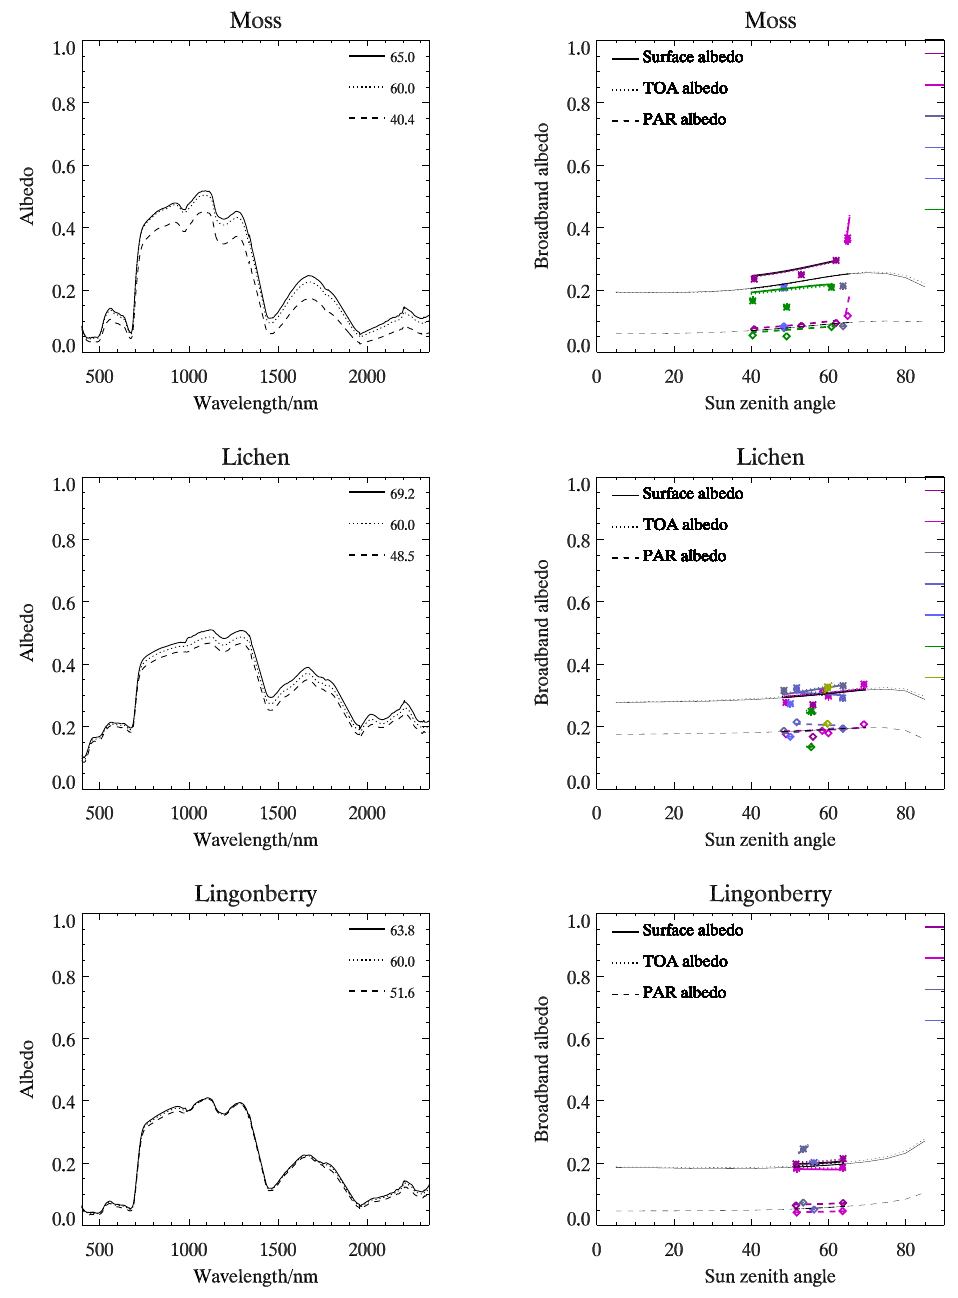
Figure 6. Left: The spectrally-resolved hemispherical albedo at three angles of incidence: maximum, minimum and 60 ◦ (interpolated). Right: recovered broadband surface albedo (solid line, +), TOA albedo (dotted line, x) and PAR albedo (dashed line, diamond) as a function of the solar zenith angle, as in Figure 4. The targets are from top down: moss, lichen, and